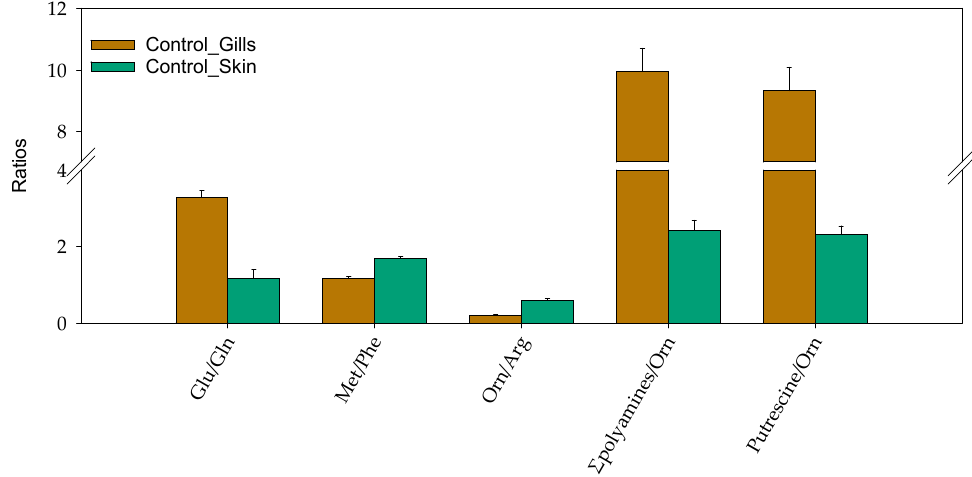
Figure 3. The ratios of metabolites that significantly differentiated the skin and gill mucus samples (Glu, glutamic acid; Gln, glutamine; Met, methionine; Phe, phenylalanine; Orn, ornithine; Arg, arginine; ∑ polyamines = (putrescine + spermidine)).